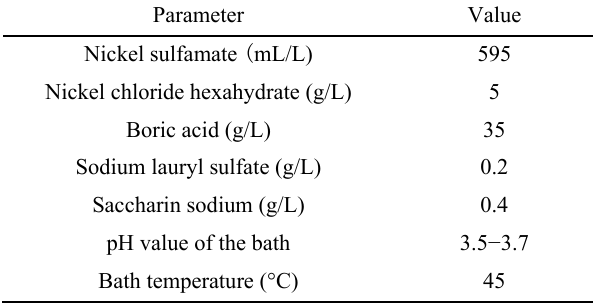
parameters for the electrochemical deposition of nanocrystalline